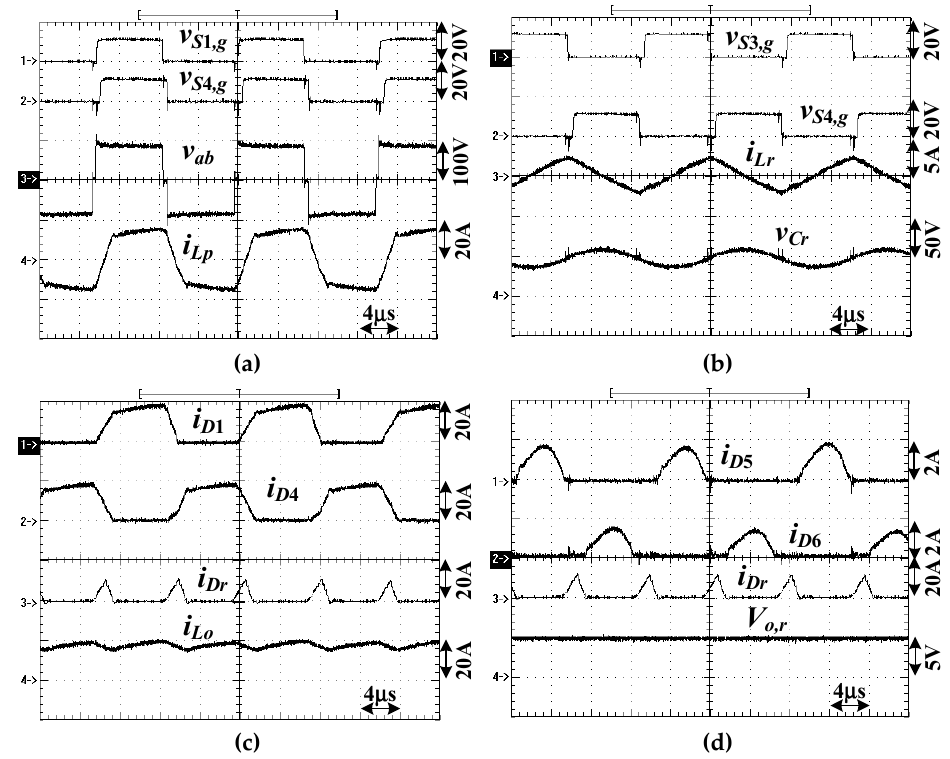
Figure 6. Experimental results at V in = 90 V and full load under low voltage input region ( a ) v S 1 ,g , v S 4 ,g , v ab , and i Lp ( b ) v S 3 ,g , v S 4 ,g , v Cr , and i Lr ( c ) i D 1 , i D 4 , i Dr , and i Lo ( d ) i D 5 , i D 6 , i Dr , and V o,r .